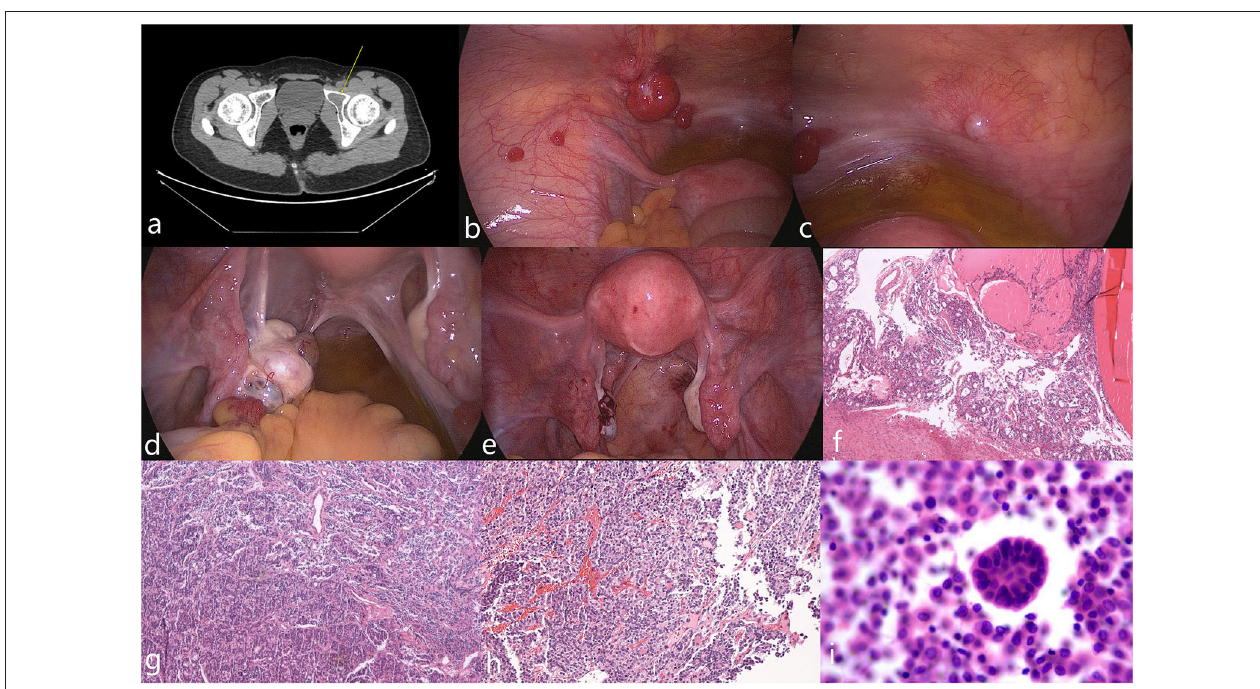
FIGURE 1 | Imaging, intraoperative, and pathological photos of typical appearance of MSO metastasized to peritoneum (case 3). (a) Pelvic CT showed lesion on left acetabulum (arrow). (b,c) Multiple smooth pink nodules distributed spread on peritoneum with diameters that varied from 5mm to 2cm were noted. Ascites was mild with a clarified faint yellow color. (d) The left ovary was enlarged; a pink nodule on its surface with a 1-cm in diameter was noted. (e) Postoperative appearance of the pelvic cavity. (f–h) Pathological examinations of the left ovary, peritoneal nodules and left acetabular lesion showed features of MSO. (i) Malignant tumor cells were found in peritoneal